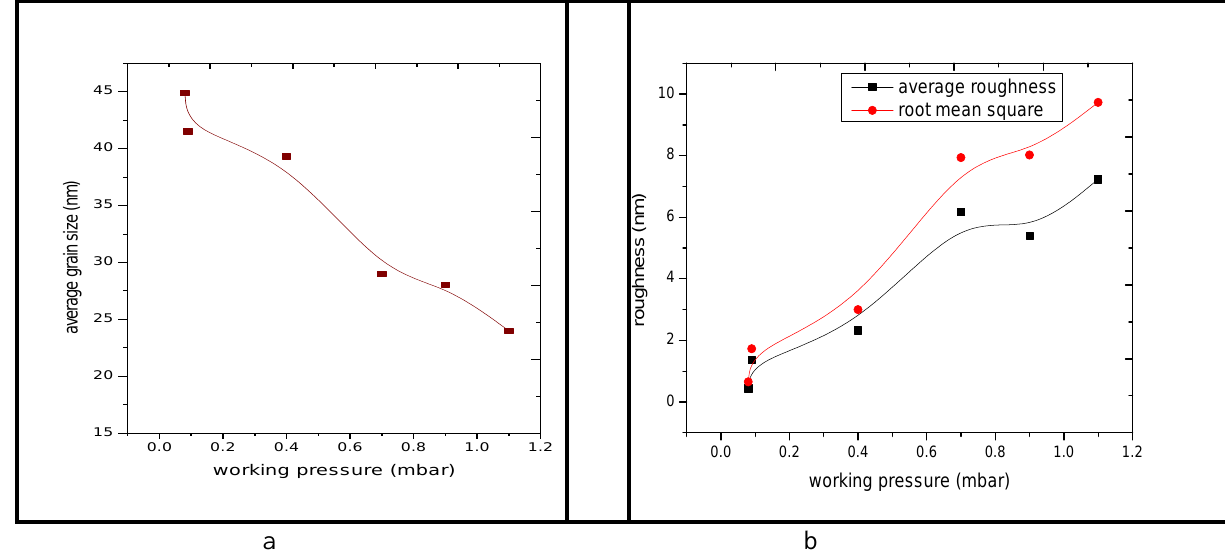
Fig. 4: Average grain size, average roughness, and the root mean square at different working